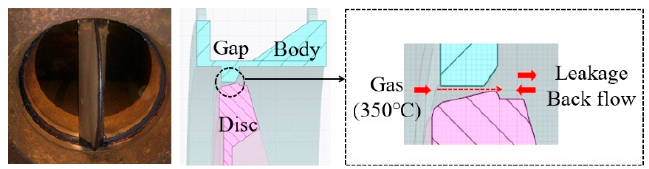
Figure 1. The existing damper valve.